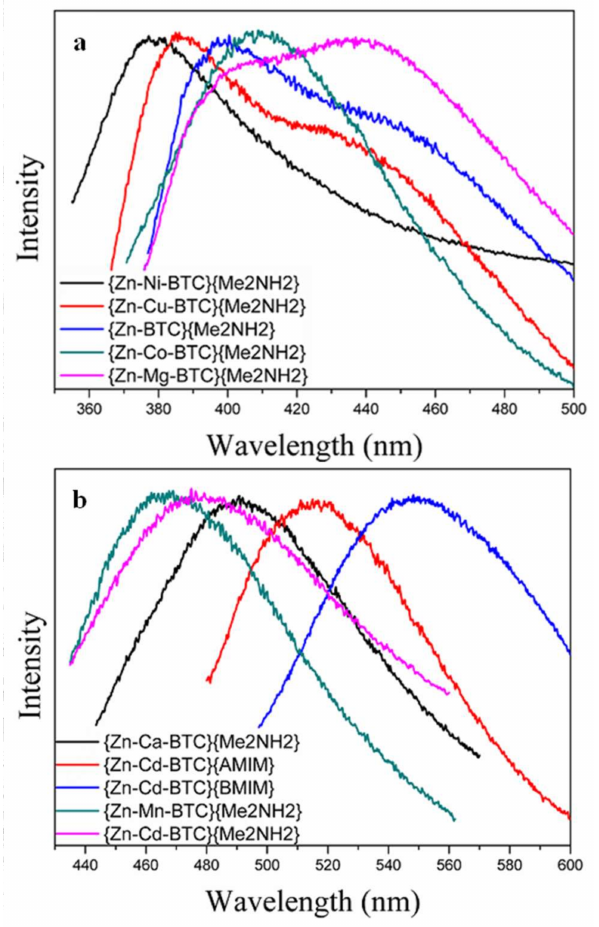
Figure 6. Photoluminescence emission of {Zn-M-BTC}{Me 2 NH 2+ } ( a ) and {Zn-Cd-BTC}{AMIM/BMIM} in comparison with {Zn-M-BTC}{Me 2 NH 2 + } ( b ) MOF systems registered in ambient